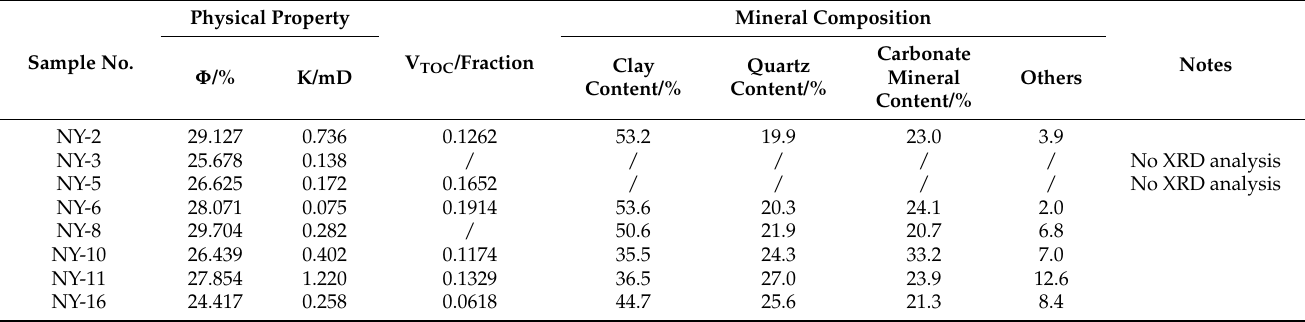
Table 1. XRD whole-rock test